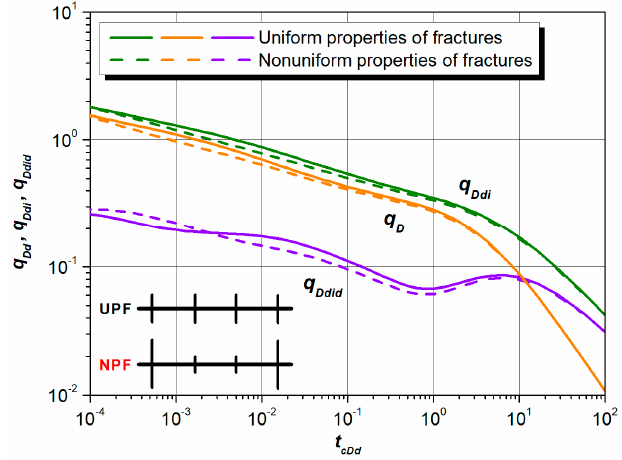
Figure 3. The combined type curves of an MFHW with UPF and NPF respectively.